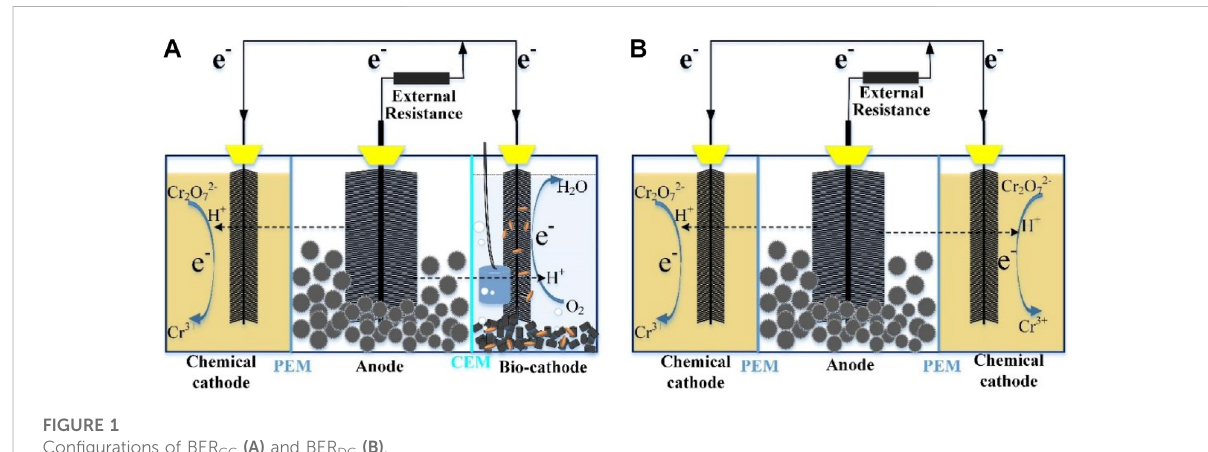
FIGURE 1 Con fi gurations of BER CC (A) and BER DC (B)